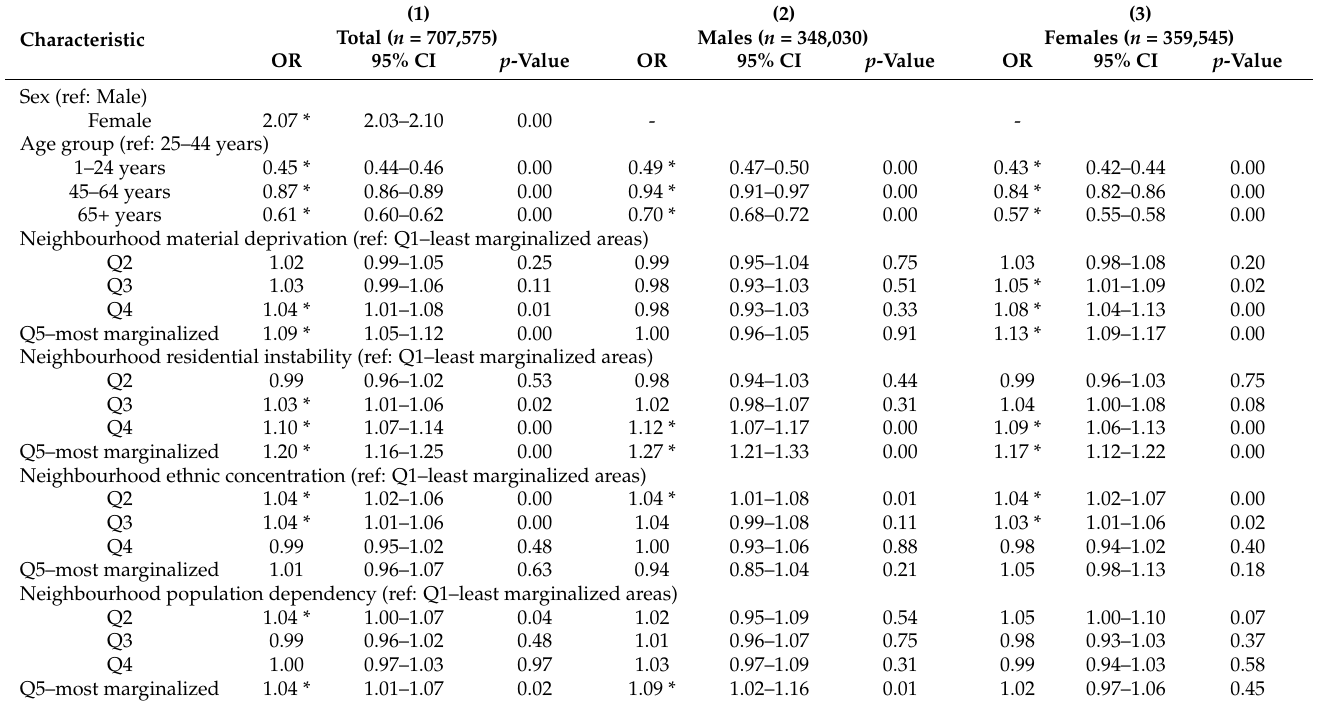
Table 2. Adjusted odds ratios (and 95% confidence intervals) for the risk of healthcare utilization for mood and anxiety disorders—regression models disaggregated by sex at the individual